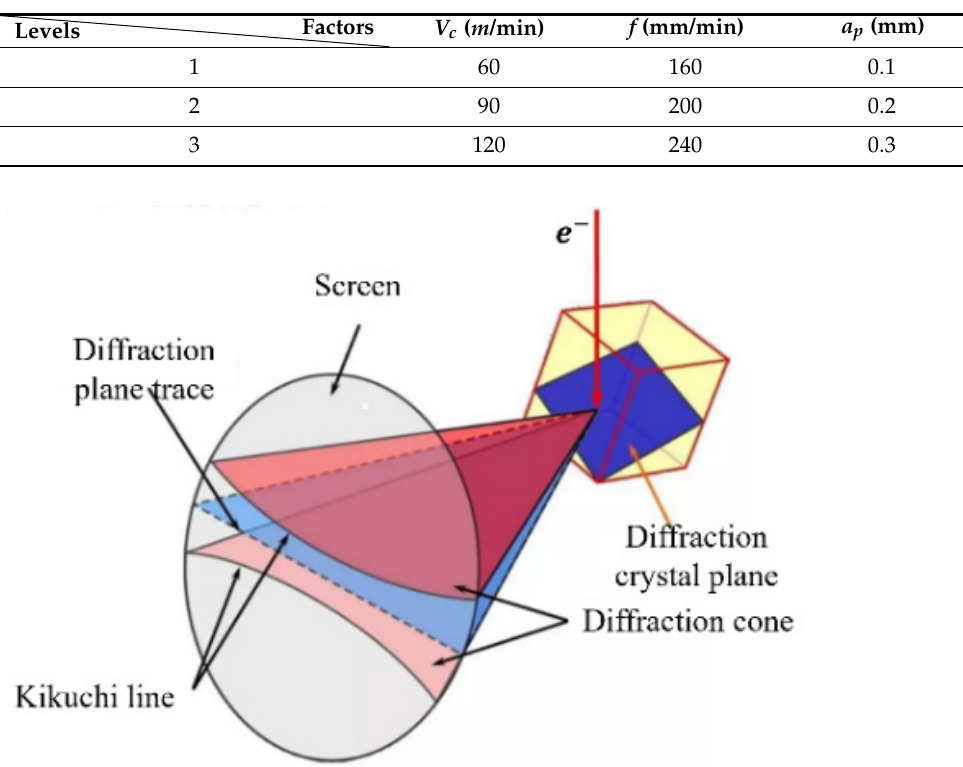
Table 2. Orthogonal experimental parameters.